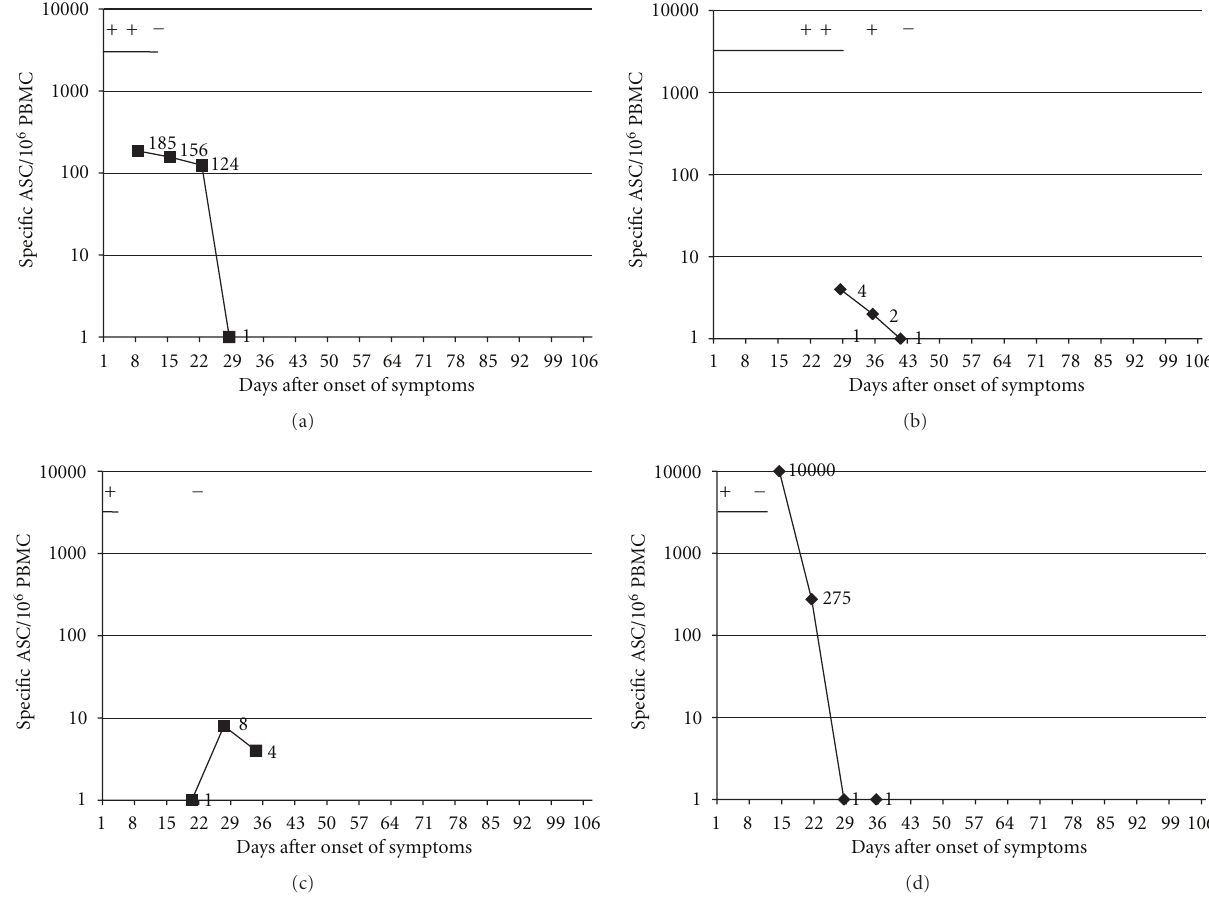
Figure 4: Relation of pathogen-specific circulating plasmablasts (black curve) with symptoms (black horizontal line) and findings in stool samples (+ or − ) in four patients with gastroenteritis caused by (a) Salmonella typhimurium , (b) S. emek , (c) S. bradburg, and (d) Campylobacter jejuni . The plots represent each data from one individual. The day of the onset of the symptoms was marked as day 0.